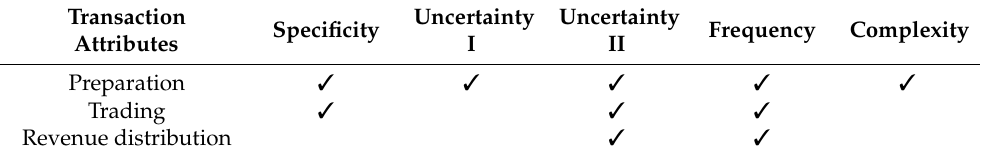
Table 1. Transaction attributes of the three transaction stages of CCCL